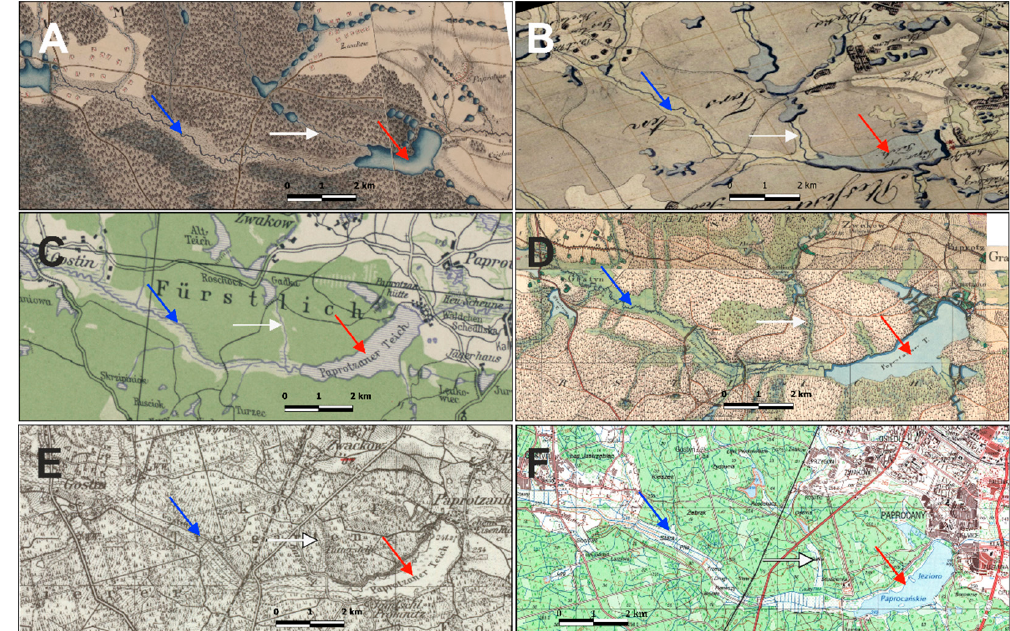
Figure 2. Paprocany reservoir over the centuries—fragments of the map: Christian Friedrich von Wrede 1748 ( A ); Situations Plan von einem Theile Oberschlesiens an der Oestereich – und Neuschlesischen Grenze, Johannes Harnisch, 1794 / 1795 r. ( B ); Friderizianische Siedlungen rechts der Oder bis 1800 (1933) ( C ); Lieutenant von Sydow from the Border Guard regiment 1827 ( D ); Topographische Karte 1:25 000 (Meßtischblatt 3422 5979) 1944 ( E ); topographic map ( F ). Red arrow shows the Paprocany reservoir, white arrow shows the Potok Ż wakowski Stream and blue arrow the Gostynia River.